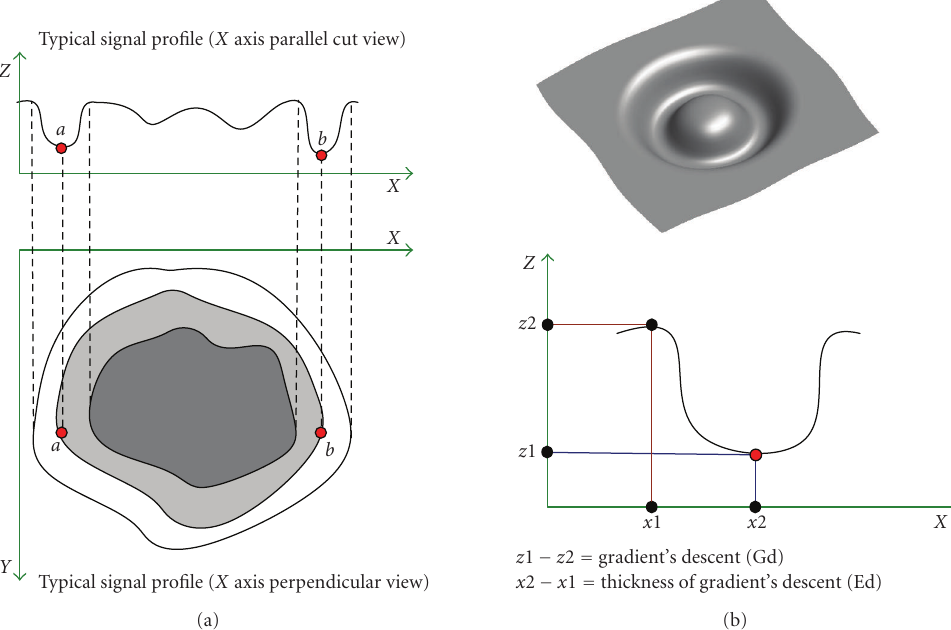
Figure 4: The signal profile typically presents two steep ascents and two steep descents. The algorithm uses the gradient’s descent (Gd) and its respective thickness (Ed) to identify the contour of the drops.